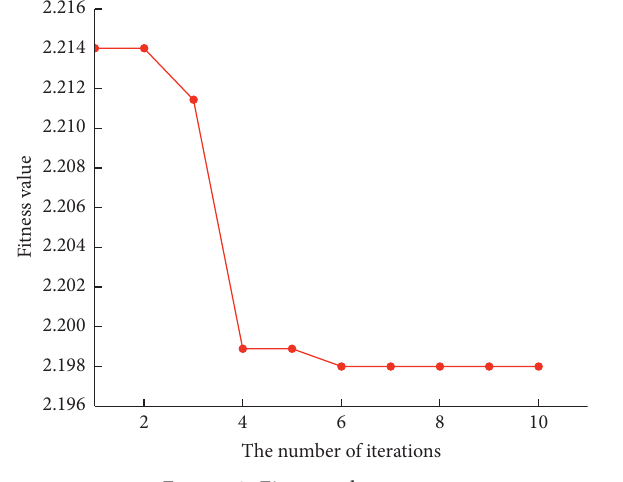
Figure 8: Fitness value curve.